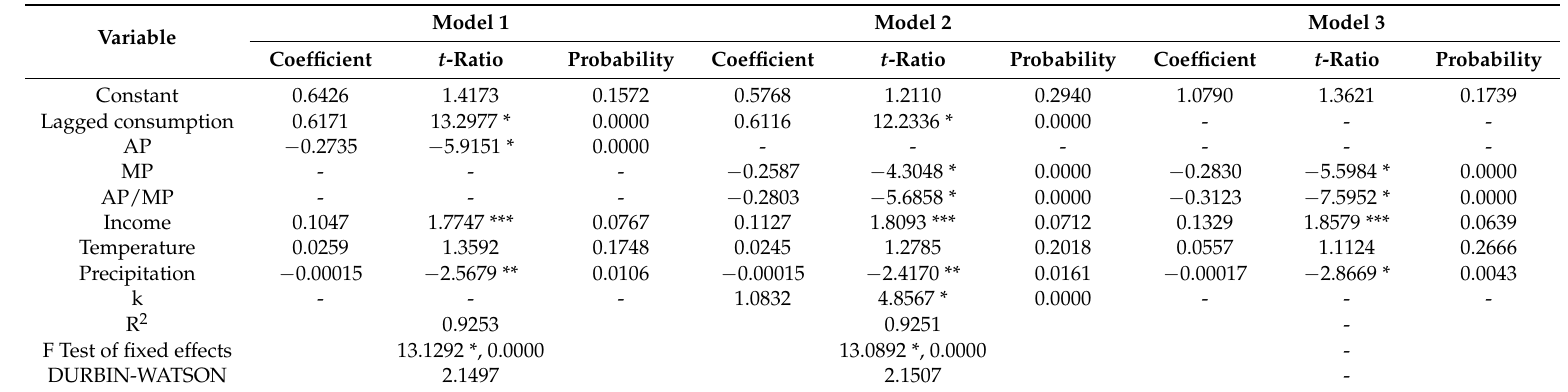
Table 4. Estimates of the dynamic